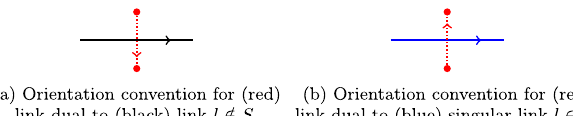
˜ P FIG. 7. Conventions for the orientation of links in (dotted red line) from branching structure of triangulation T (solid black line). Nonsingular (singular) black (blue) links l ∉ S ( l ∈ S ) ˜ P induce orientation conventions for the dual link in . We introduce a spinless fermion on each (black or blue) link in T and split it into two Majorana fermions on the two sides of this ˜ P link or vertices of (red